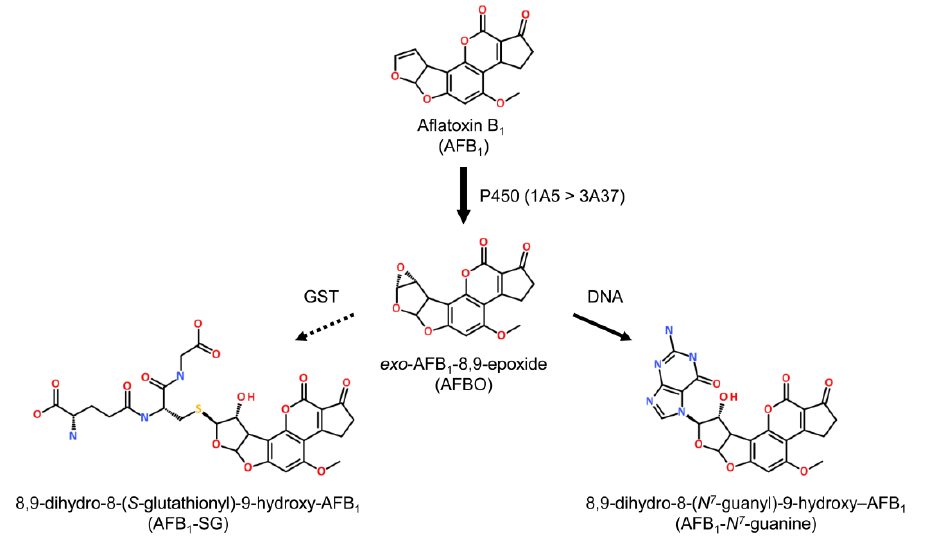
Figure 2. Metabolites and enzymes involved in aflatoxin B 1 (AFB 1 ) metabolism in the turkey liver. Arrow width shows reaction efficiency (wide > narrow), while a dashed line indicates that a reaction does not occur in all birds. Cytochrome P450 ( CYP ) enzymes effectively interact with AFB 1 . Domestic turkey glutathione S -transferase (GST) enzymes cannot conjugate exo -AFB 1 -8,9-epoxide (AFBO), although wild and heritage turkey GST enzymes can have